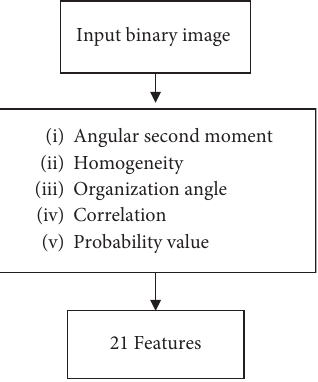
Figure 3: The developed model.